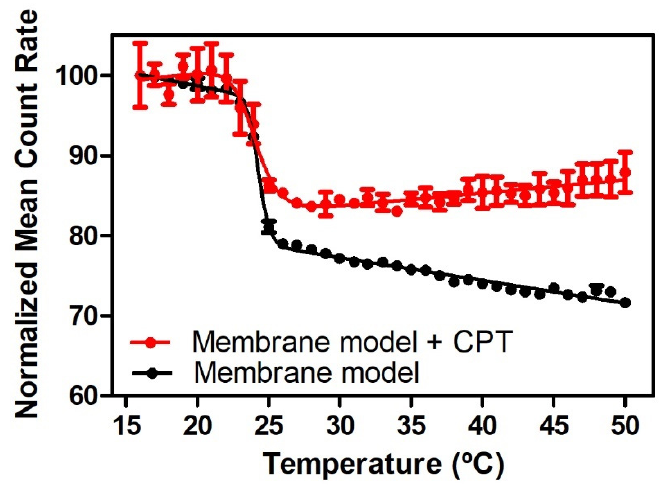
Figure 5. Normalized MCR of DMPC membrane models in absence ( • ) and in the presence of CPT ( • ) as a function of temperature. Each point corresponds to the mean value ± standard deviation of three experiments. Continuous lines are the best fits according to Equation (8).